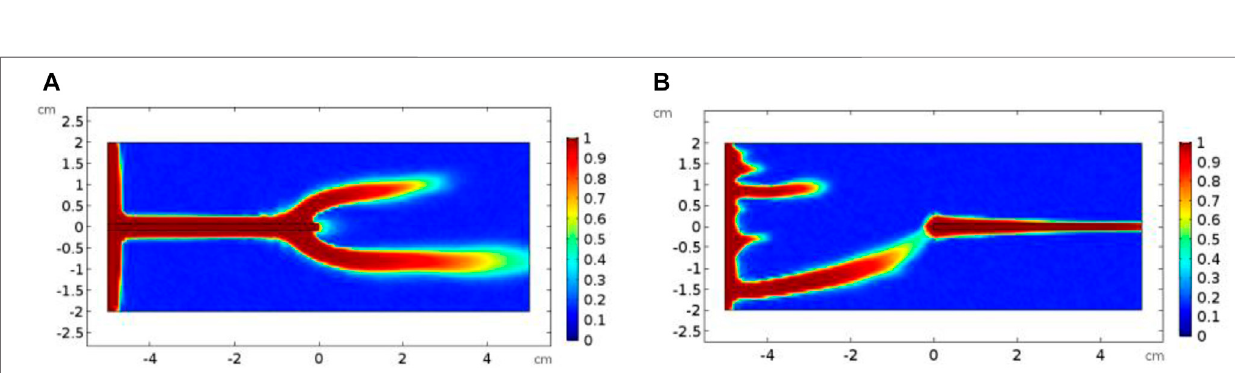
Frontiers in Earth Science |